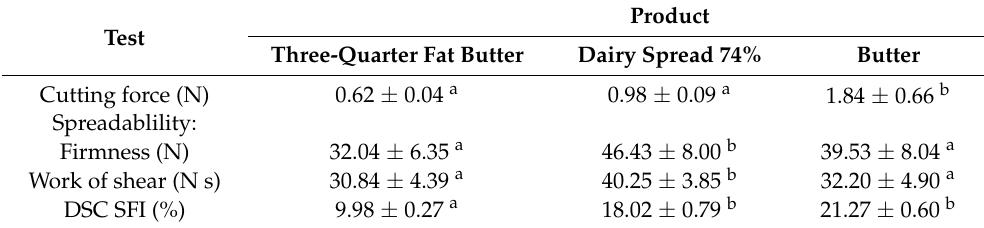
Table 4. Texture and solid fat index of the analysed products at 20 ◦